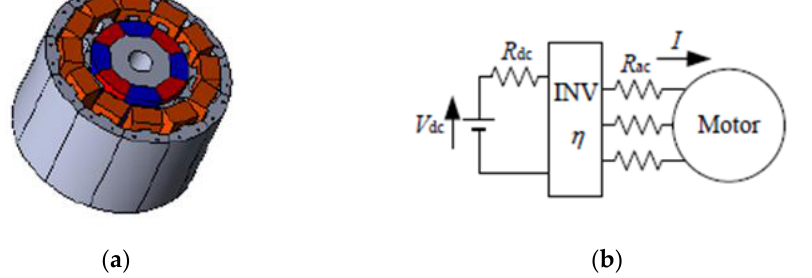
Figure 4. Torque – current density comparison.